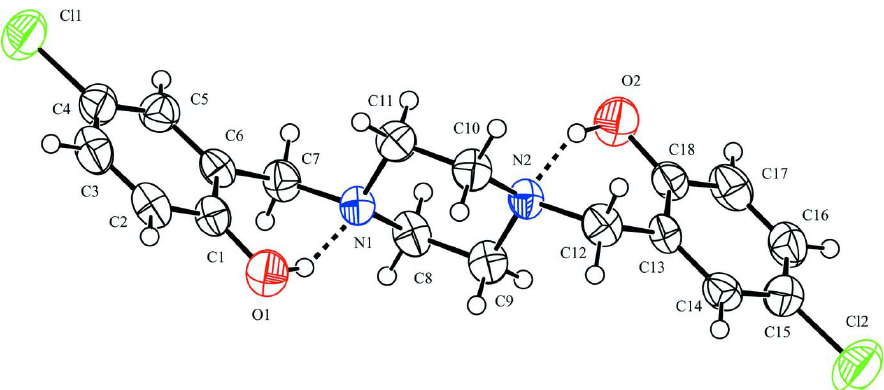
Figure 1 The molecular structure of (I) with the atom-labelling scheme and displacement ellipsoids are drawn at the 50% probability level. H atoms are represented by circles of arbitrary size.